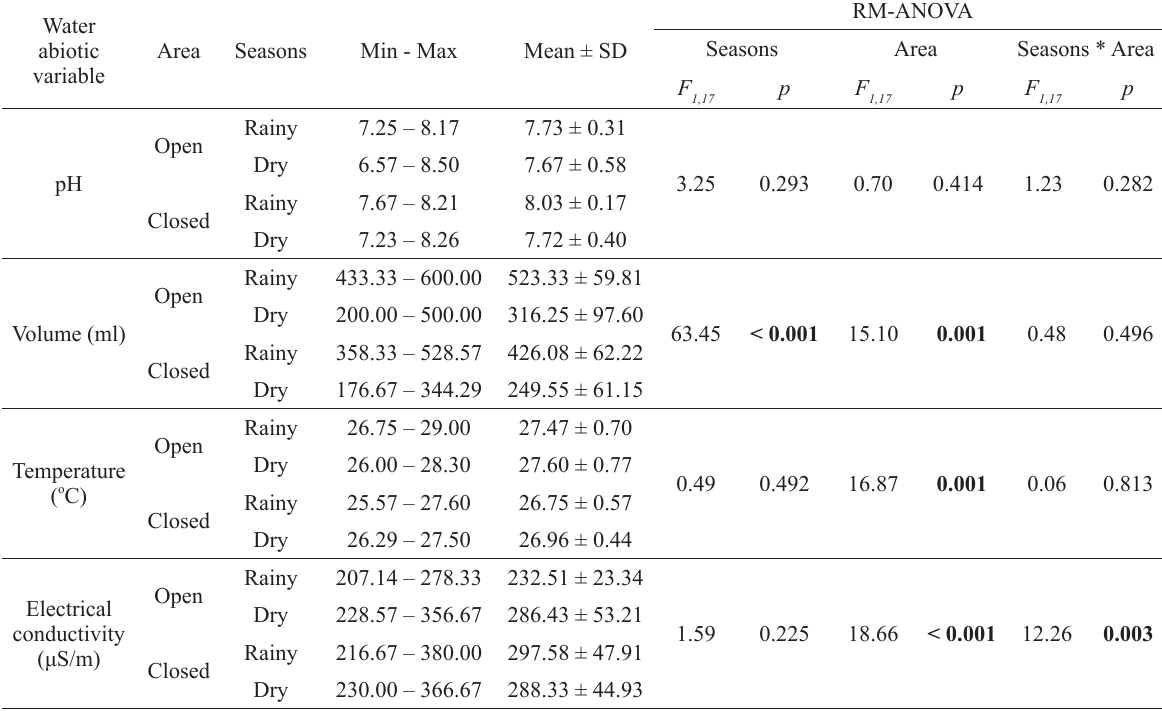
Results of Repeated Measure Analysis of Variance (RM-ANOVA) to test differences in abiotic variables between studied seasons and area; minimum (Min), maximum (Max), mean, and standard deviation (SD) values of abiotic variables in artificial containers in an urban forest fragment in Central